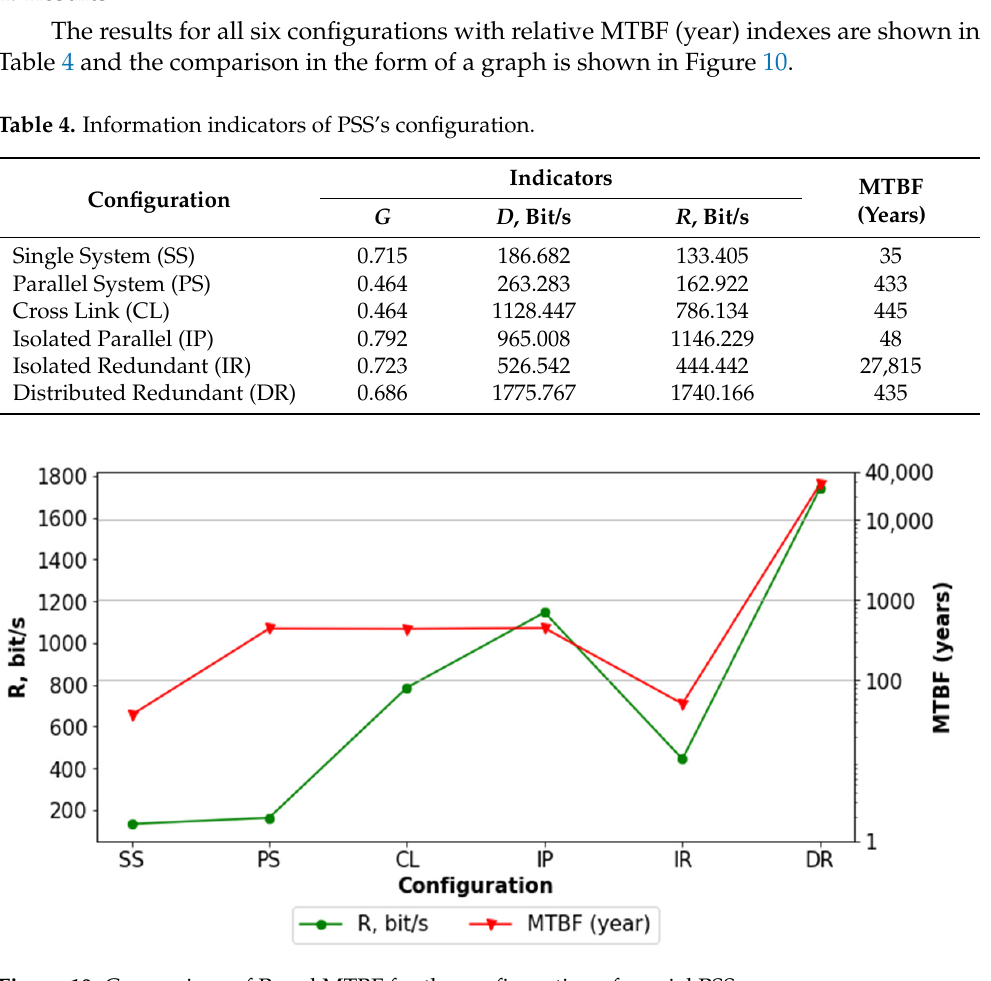
Table 3. Determination of informational indicators in the Parallel System.